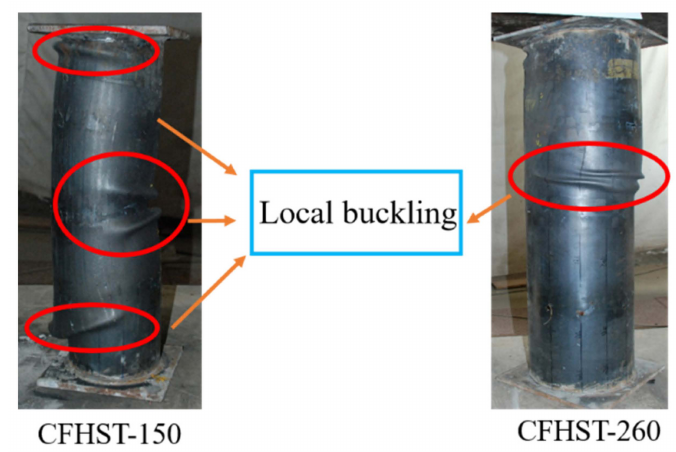
Figure 5. Loading methods and boundary conditions of FEM.